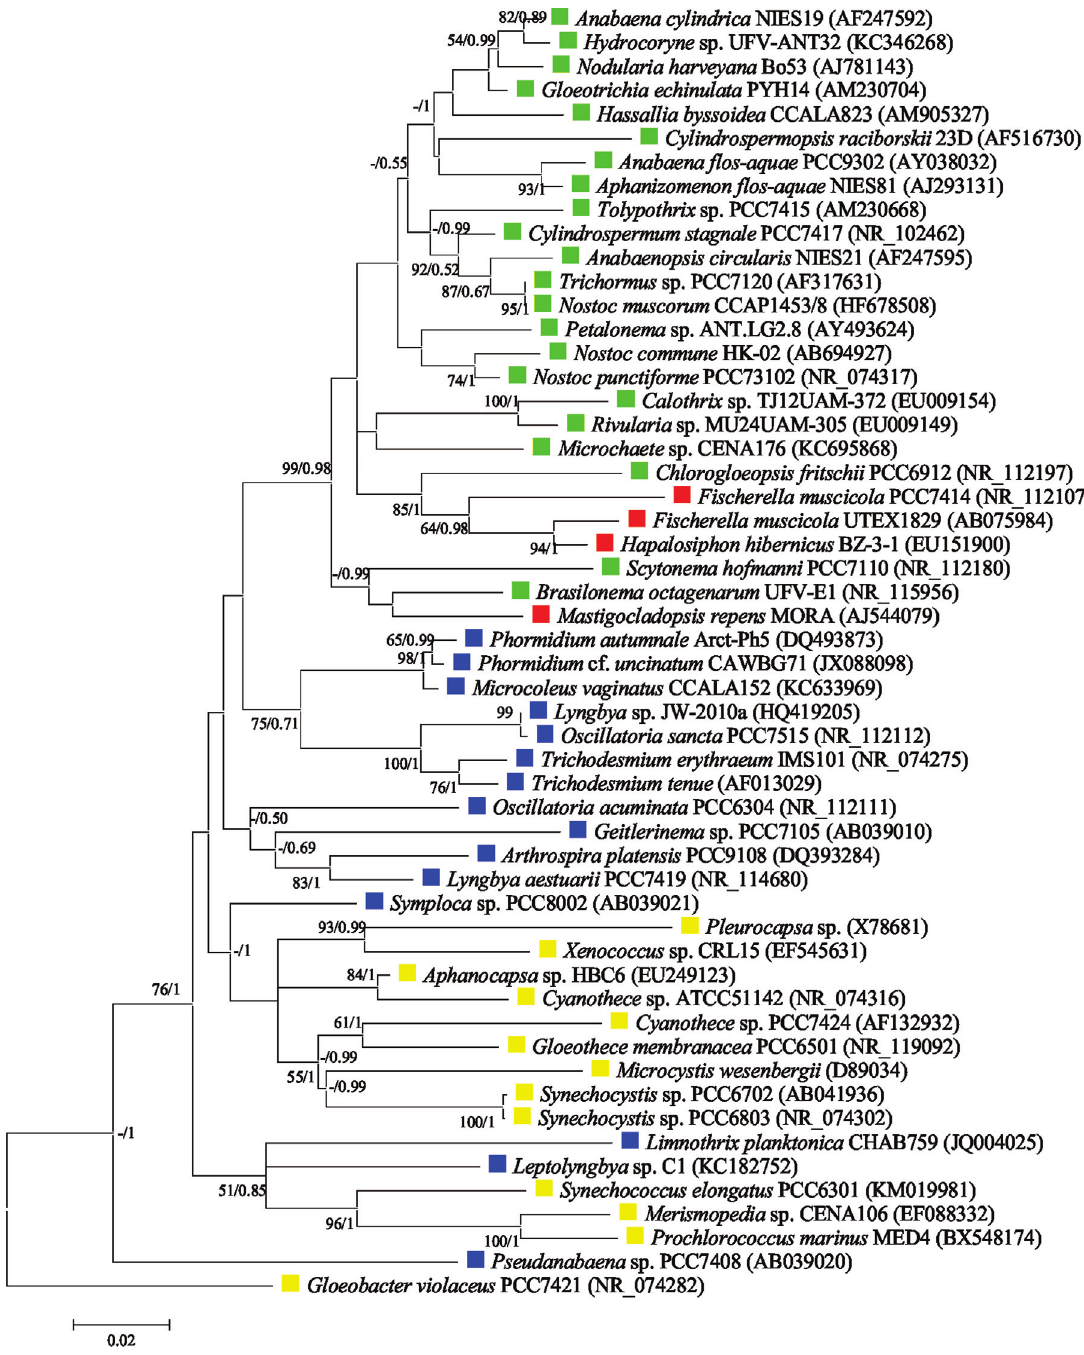
Figure 4 - Maximum Likelihood (ML) phylogenetic reconstruction based on partial 16S rRNA sequences. A total of 54 sequences were used. A matrix with 1,463 base pair lenght was obtained after alingment. The general time reversible evolutionary model of substitution with gamma distribution and withanestimateofproportionofinvariablesites(GTR+G+I)wasselectedasthefittestforthealignmentbyMrModelTest2.3(Nylander,2004).Phylo- genetic trees were reconstructed using the ML and Bayesian methods. For Bayesian analysis, the trees were searched using the software MrBayes 3.2.6 (Ronquist etal. ,2012)andtheBayesiananalysisconsistedoftwoindependentruns,withfourMarkovchainseach,of50milliongenerationssampledev- ery 5,000 generations. Posterior probabilities (PP) were calculated at the conclusion of the Markov-Chain-Monte-Carlo analysis and a traditional burn-in on the first 25% of the trees was performed. The ML trees were reconstructed using the MEGA program package, version 5 (Tamura et al. , 2011). The ro- bustness of the phylogenetic trees was estimated via bootstrap analysis using 1000 replications. ML and Bayesian methods resulted in nearly identical to- pologies,withindicationsofbootstrapvalues(ML)andBayesianPPsintherelevantnodes.Thecyanobacterialmorphologiesarehighlightedwithdiffer- ent colours: yellow for unicellular strains, blue for filamentous non-heterocytous strains, green for filamentous heterocytous strains without branching, and red for filamentous heterocytous strains with true branching. Sequence data from this article can be found in the NCBI database under the accession numbers, which are presented together with the strain